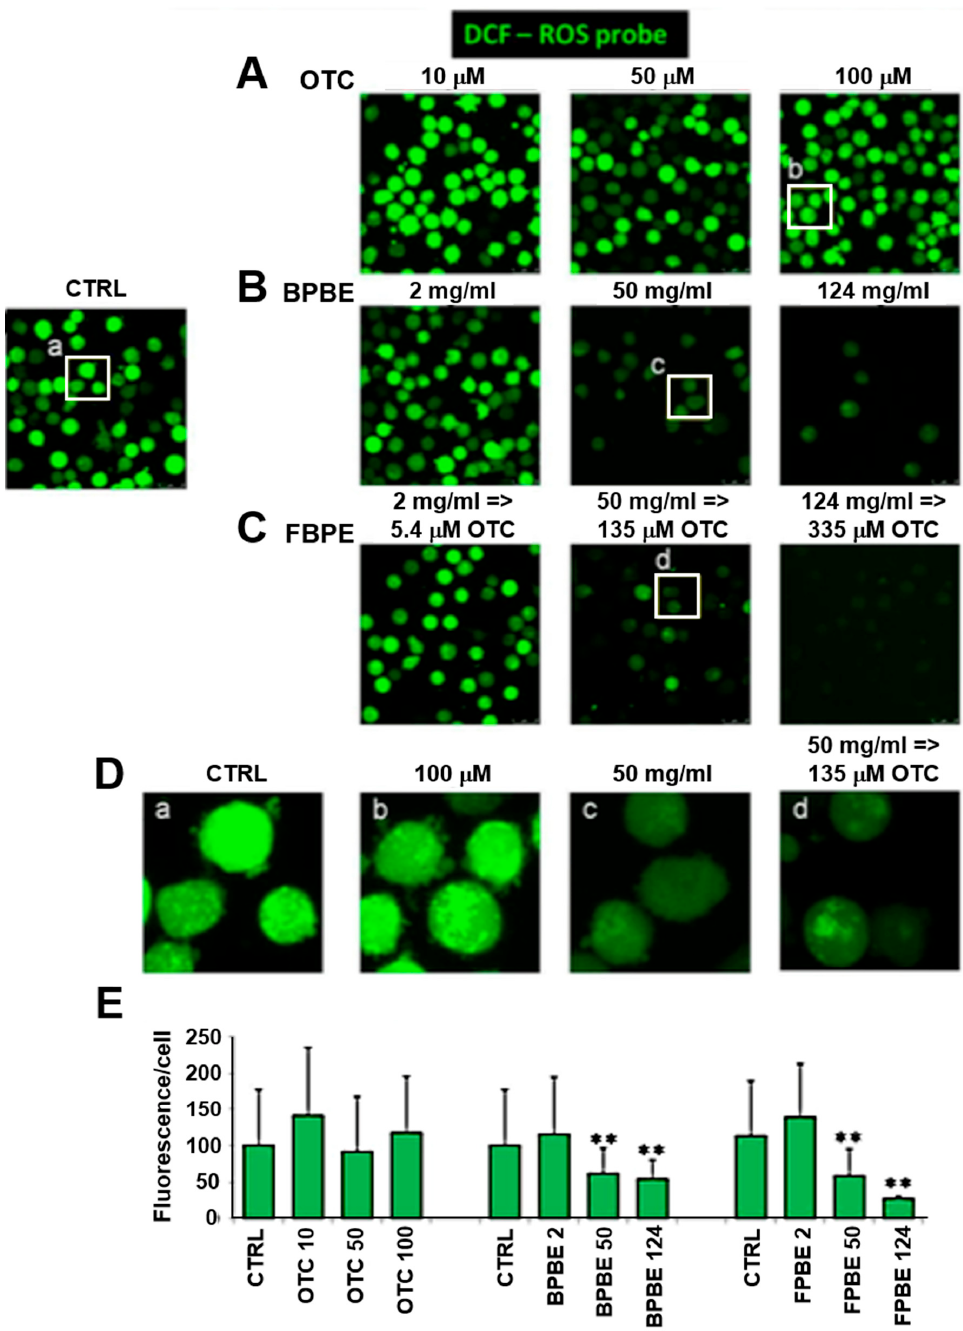
Figure 5. E ff ect of chicken bone powder treatment on the reactive oxygen species production in K562 cells. Cells were treated for 48 h with the indicated concentrations of either of OTC ( A ), BPBE ( B ), FPBE ( C ), and then incubated with 2’,7’-dichlorodihydrofluorescein diacetate (H 2 -DCFDA) and subjected to confocal microscopy analysis as detailed under Materials and Methods; untreated cells were used as control (CTRL). The images shown are from a single experiment and are representative of three independent experiments yielding similar results; ( D ) digital magnification of selected areas shown as white frames. ( E ) Quantification of the fluorescence-related pixel intensity / cell; for each condition and for each experiment, 10–15 di ff erent optical fields were randomly chosen, and the fluorescence intensity / cell averaged ± SEM; ** p < 0.01 with respect CTRL